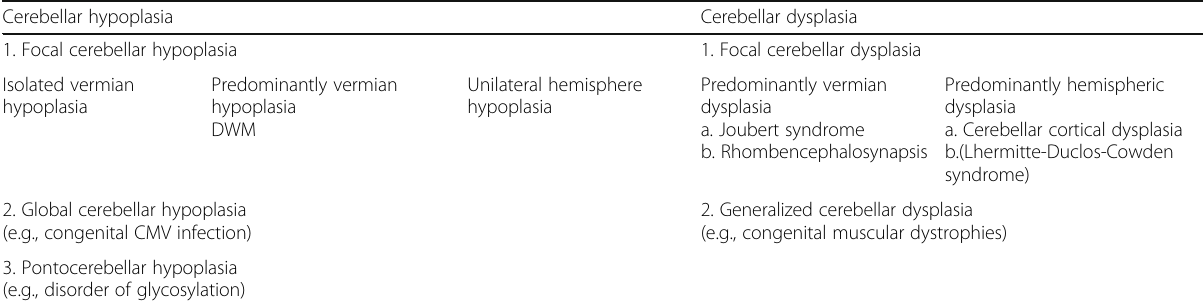
Table 3 Radiological classification of cerebellar malformation by neuroimaging criteria Cerebellar hypoplasia